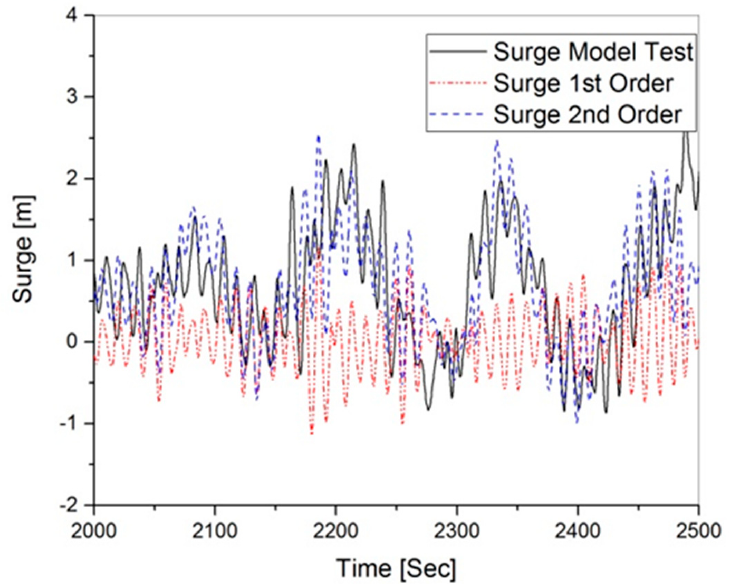
Figure 9. Time history comparison of the platform surge motion under only an irregular wave from test data and two different FAST simulations.